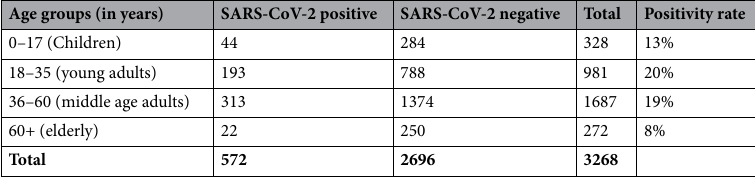
Table 1. SARS-CoV-2 age-associated infection rate.